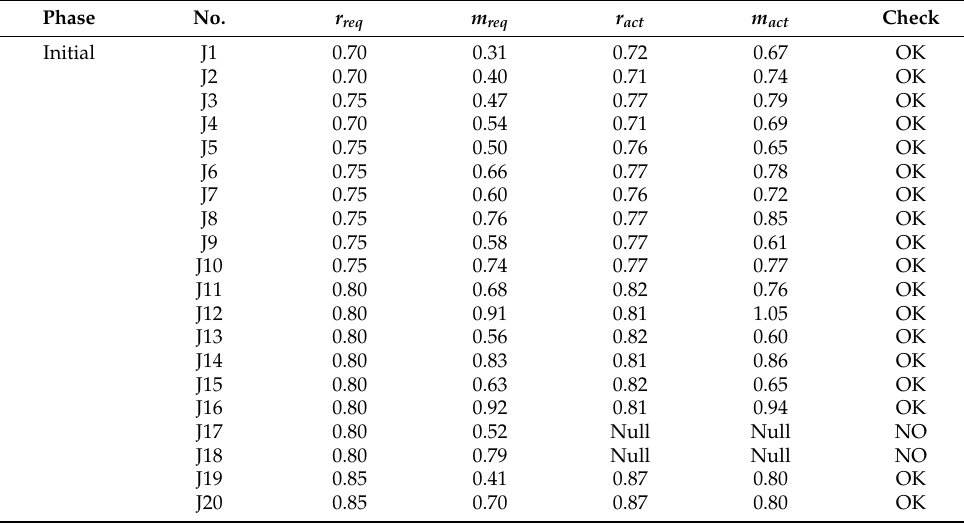
Table A4. Required and ‘actual’ connection properties in each